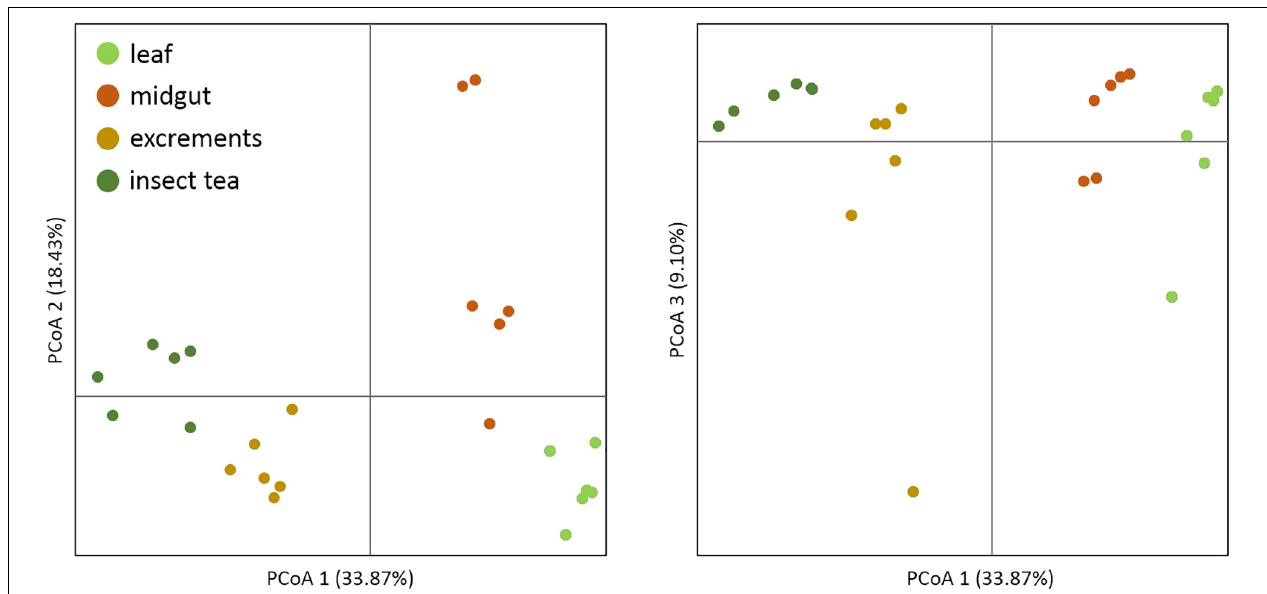
FIGURE 1 | Beta diversity assessment of different sample types. A principal coordinate analysis was conducted in order to visualize the clustering and similarity of the analyzed sample types. The three dimensions which explain the highest degree of variance were included in the visualization. Different colors of the dots indicate distinct sample types. The significance of dissimilarity between the different bacterial communities was tested with anosim in QIIME